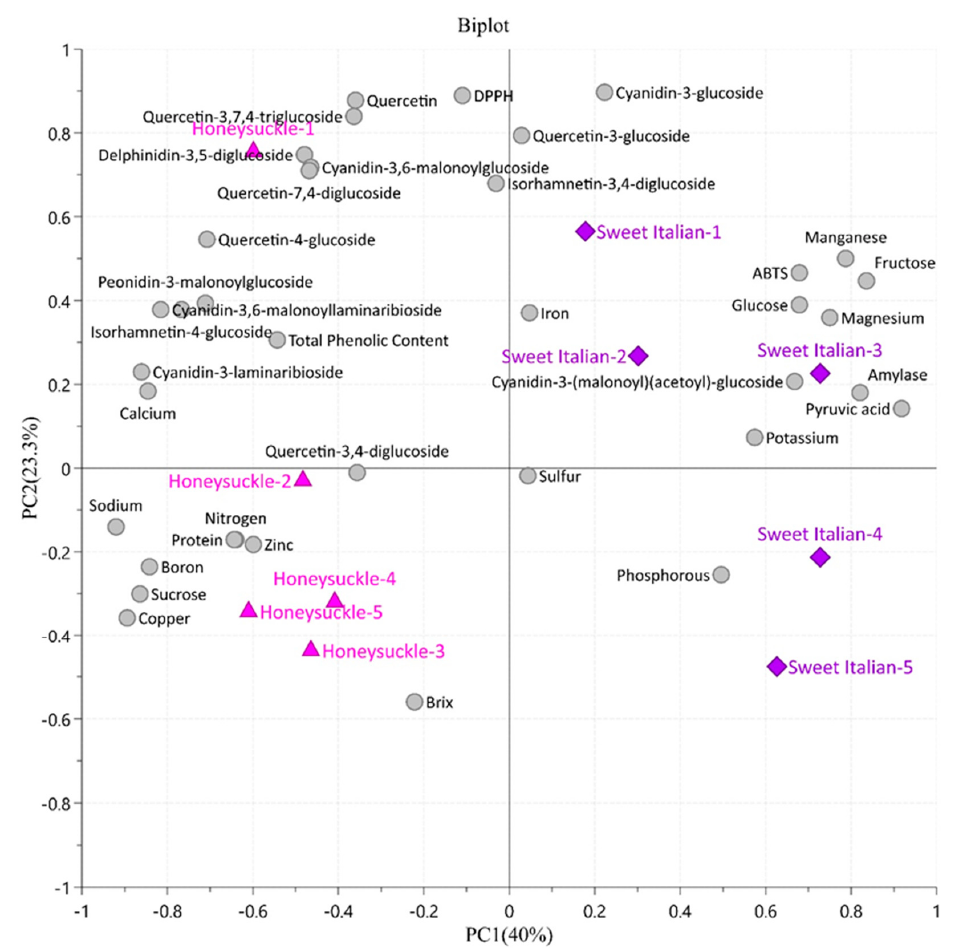
Figure 9. The biplot obtained from principal component analysis (PCA) describing the variation between honeysuckle and sweet Italian red onion cultivars and the correlation with the phytochemicals. The phytochemicals are represented as gray dots, and the cultivars are represented with the triangle (pink) and diamond (purple) markers.